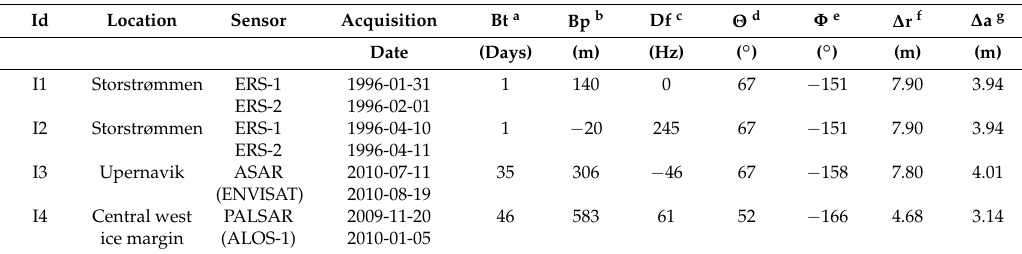
Table 1. SAR data overview. Locations are shown in Figure 1.